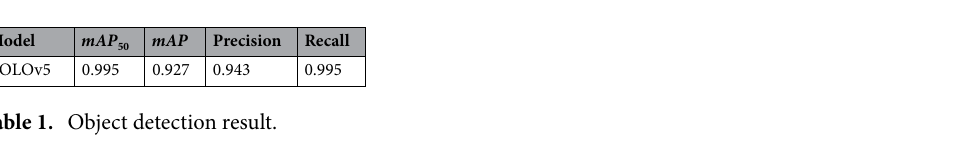
Figure 2. Intersection over union.